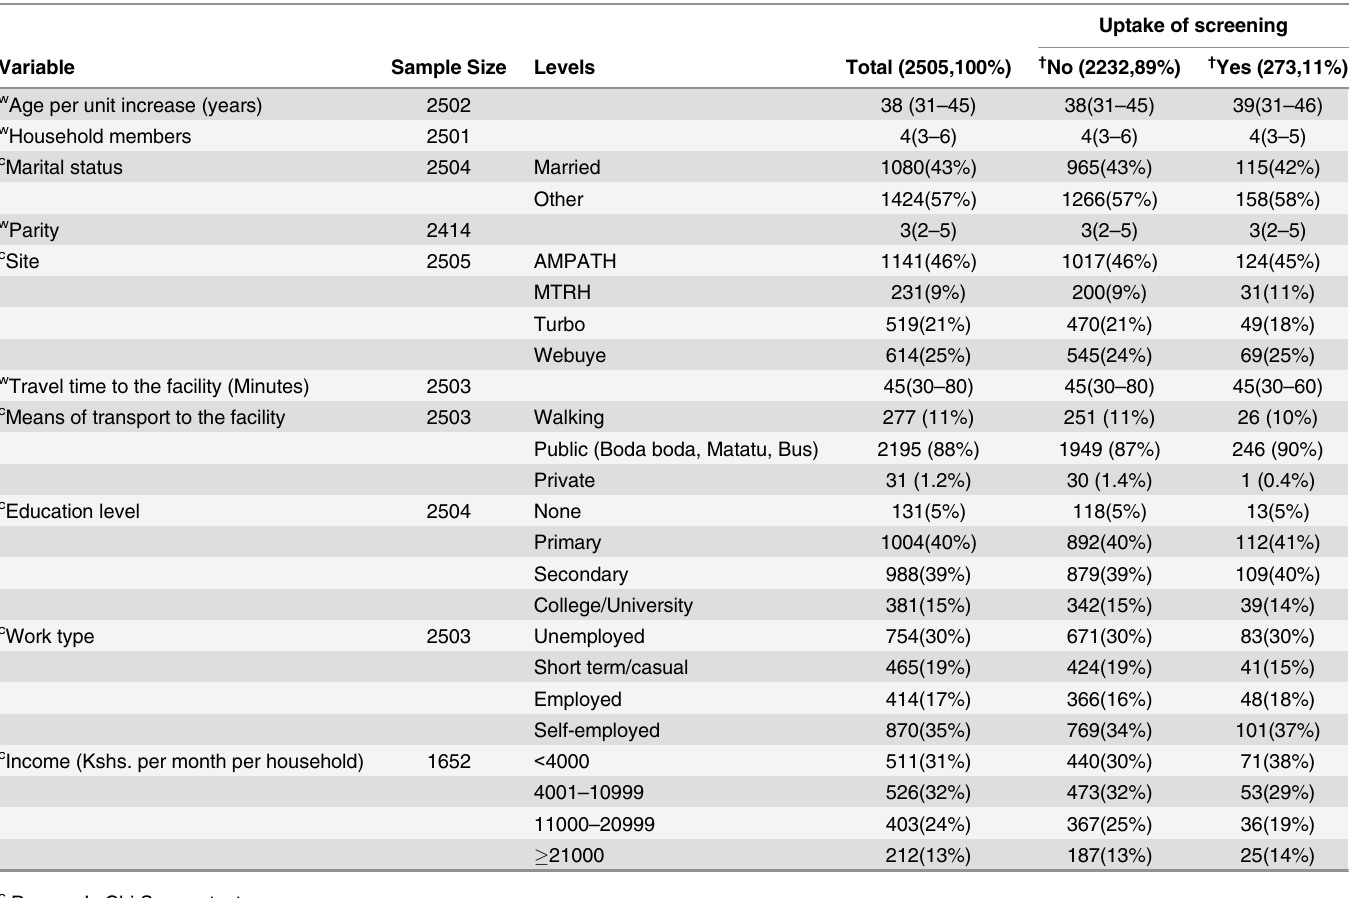
Table 1. Demographic and socio-economic